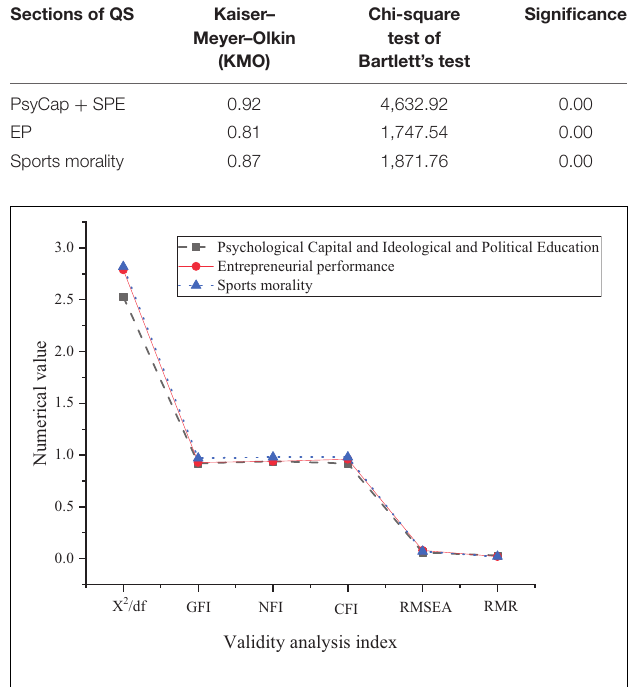
FIGURE 3 | Model fitting index.